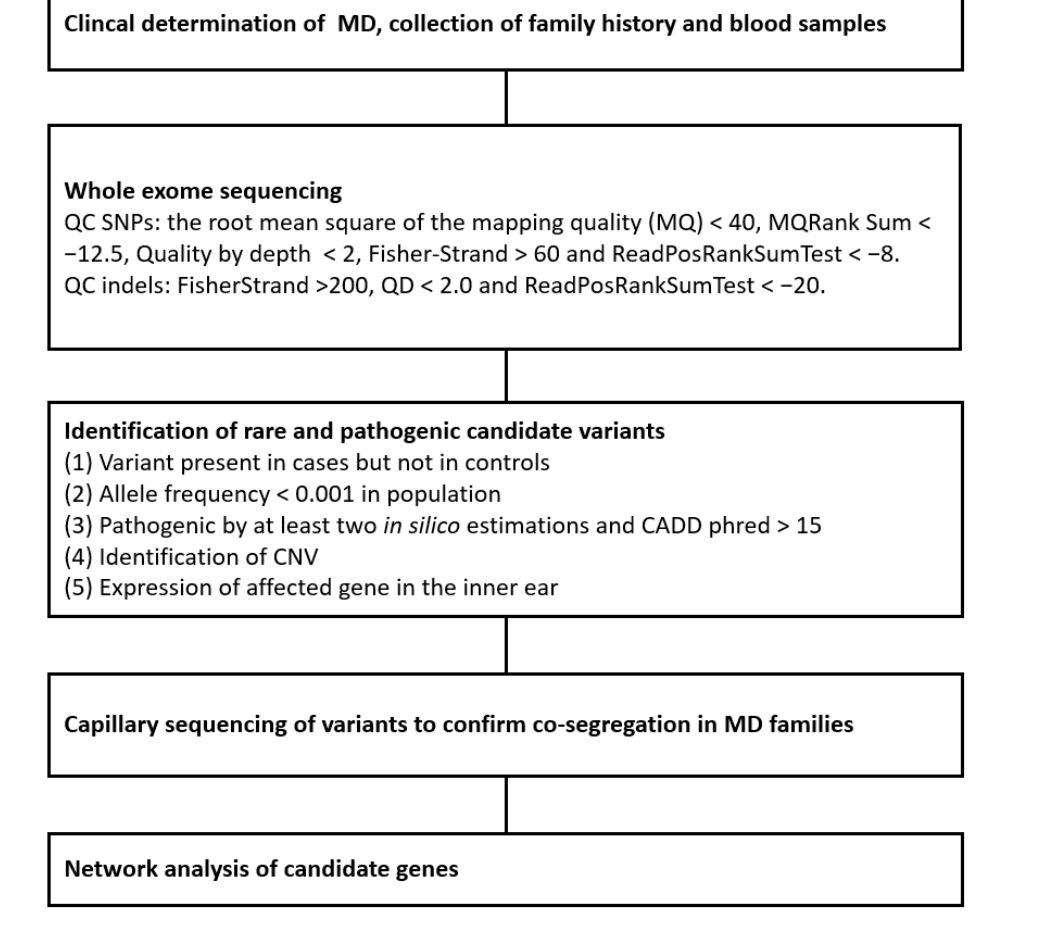
Figure 2. Flowchart of the methods used in this study.